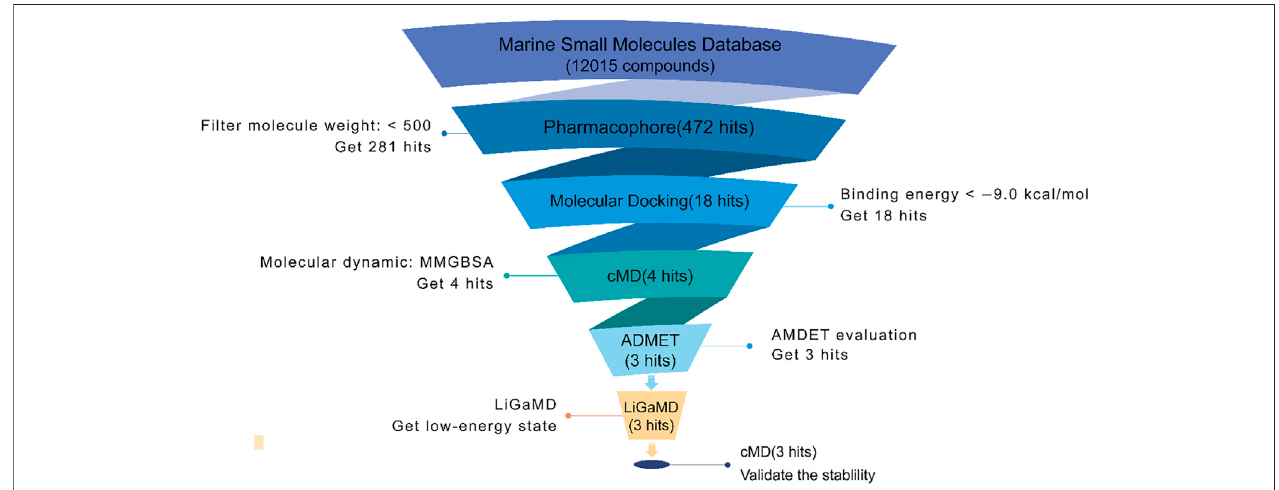
FIGURE2| Thework fl owofinhibitors screeninginthisstudy.ThepharmacophoremodelusedLigandScoutsoftware;dockingusedtheAutoDock Vinamoduleof LigandScout (Nguyen et al., 2020).